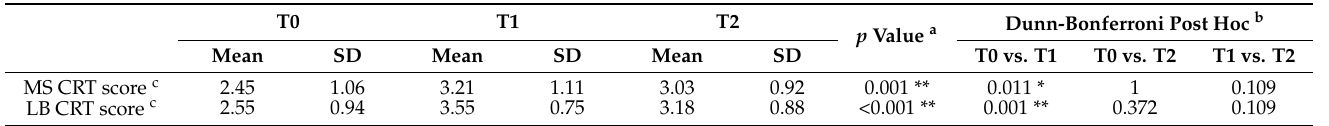
Table 1. Changes in cariogenic bacterial count scores over time and multiple comparisons between three time points. (N = 33).